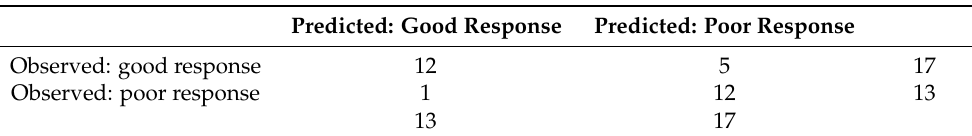
Table 3. Confusion matrix showing the combined radiomic-clinical model performance in the training cohort.